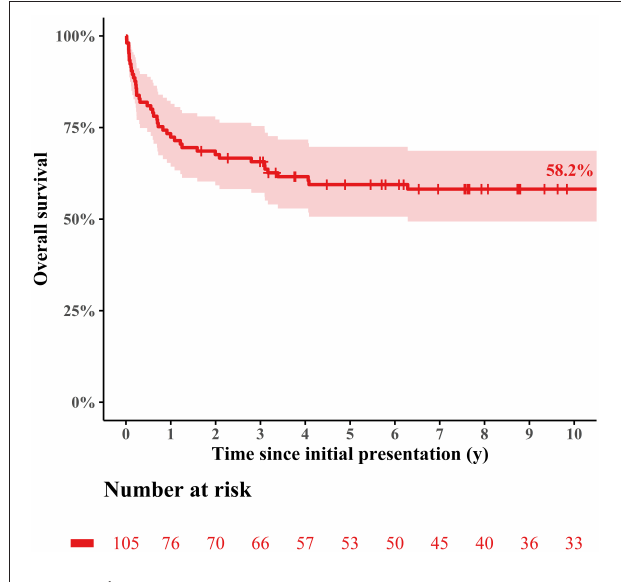
FIGURE 1 | Overall survival of the entire